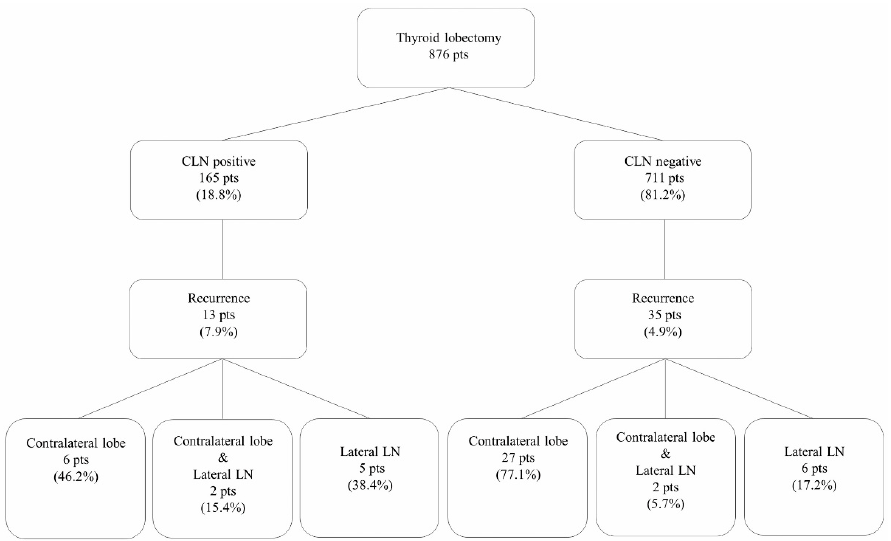
Figure 1. Recurrence in the CLN-positive and CLN-negative groups. Abbreviations: CLN: Central lymph node; LN: Lymph node; pts: Patients.